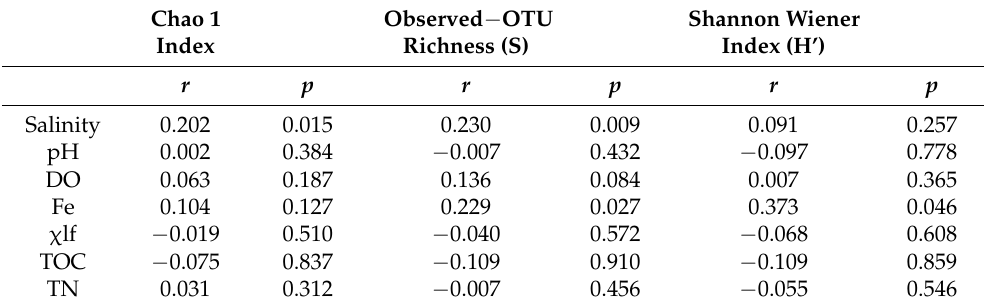
Table 1. Relationship between chemical properties and bacterial α -diversity across samples of